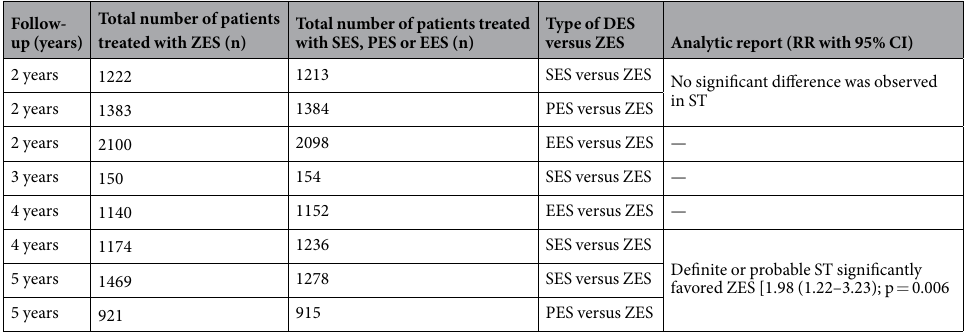
Table 6. Comparison of outcomes according to the follow-up periods. Abbreviations: ZES: zotarolimus eluting stents, SES: sirolimus eluting stents, PES: paclitaxel eluting stents, EES: everolimus eluting stents, DES: drug eluting stents, RR: risk ratios, CI: confidence intervals, ST: stent